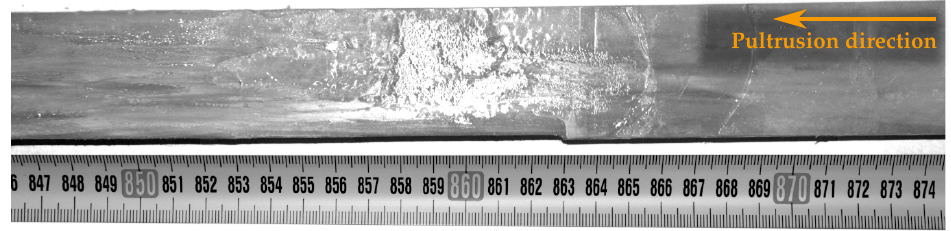
Figure 15. Material at 860cm with wedge at